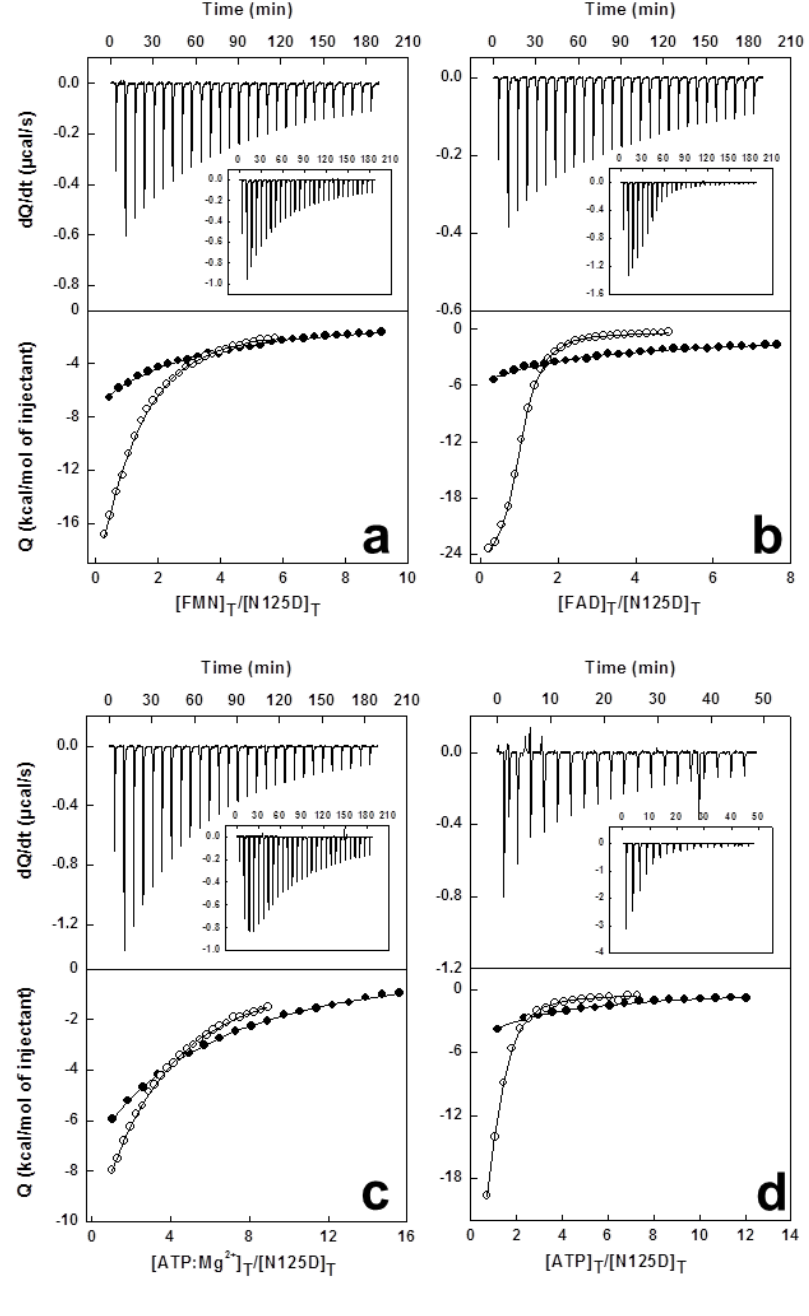
Figure 3. Calorimetric titrations of N125D and WT Ca FADS (~20 µM) with: ( a ) FMN (200 µM), ( b ) FAD (200 µM), and ( c , d ) ATP (300 µM). Upper panels show thermograms for the N125D and WT (inset) interaction, and lower panels the corresponding binding isotherms with integrated heats for N125D (●) and WT (○). Experiments carried out